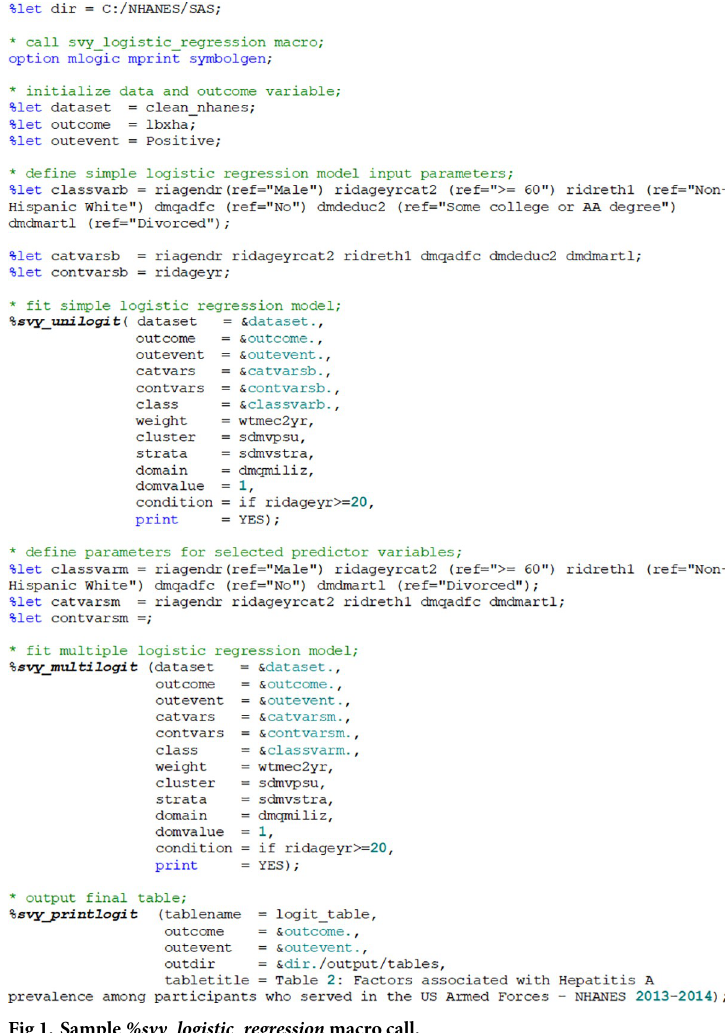
Fig 1. Sample %svy_logistic_regression macro